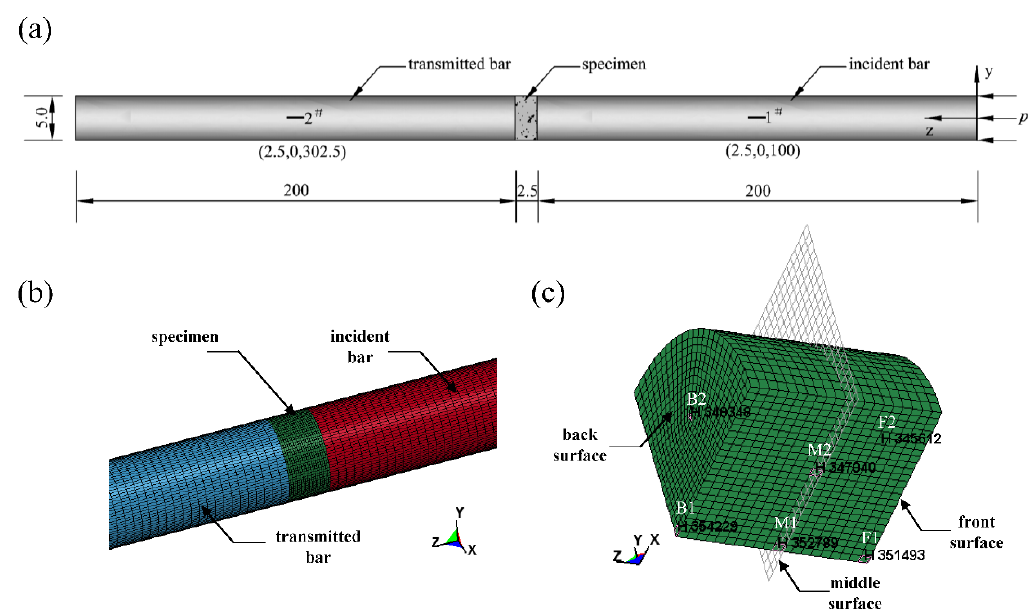
Figure 7. Numerical model of SHPB systems. ( a ) SHPB system and gage points at the bars (unit: cm). ( b ) Local model. ( c ) Specimen and gage points.